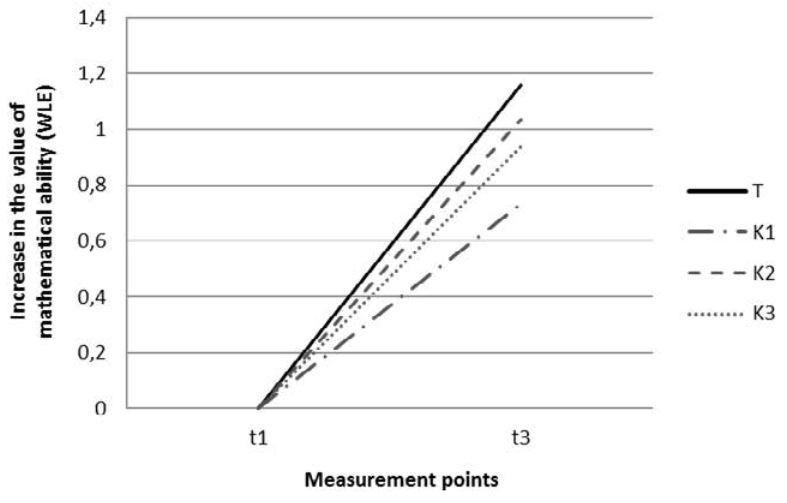
Figure 4: Learning gains among individual groups of